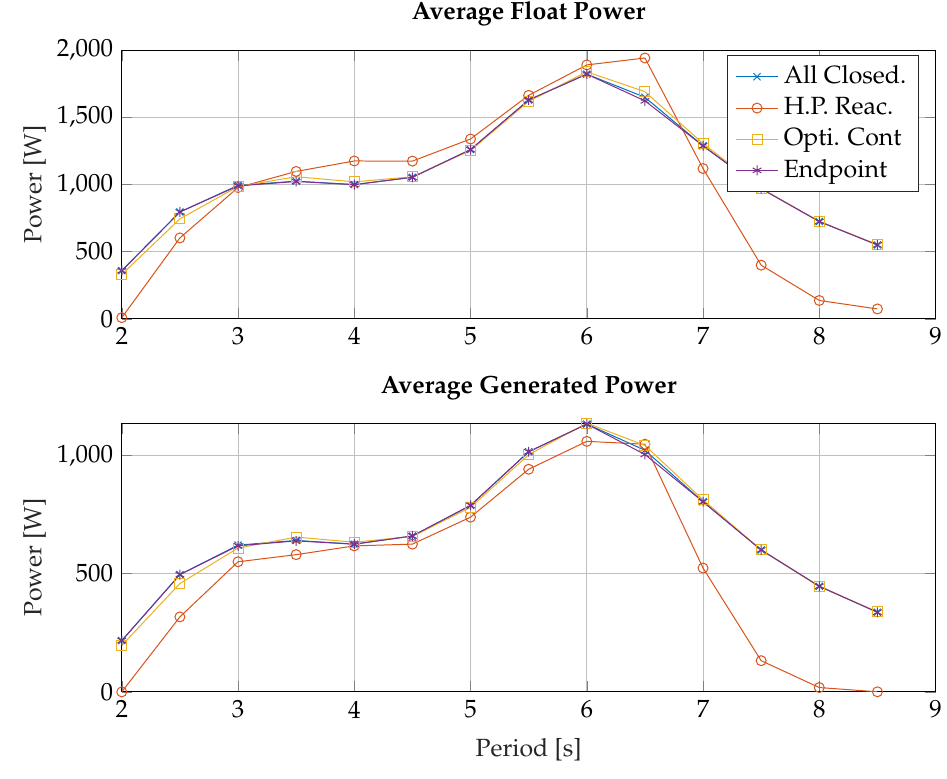
Figure 13. Frequency sweep comparison of resistive WPEAs versus reactive with pressure-dependent generator control. Wave input: regular wave of 0.35 m at varying